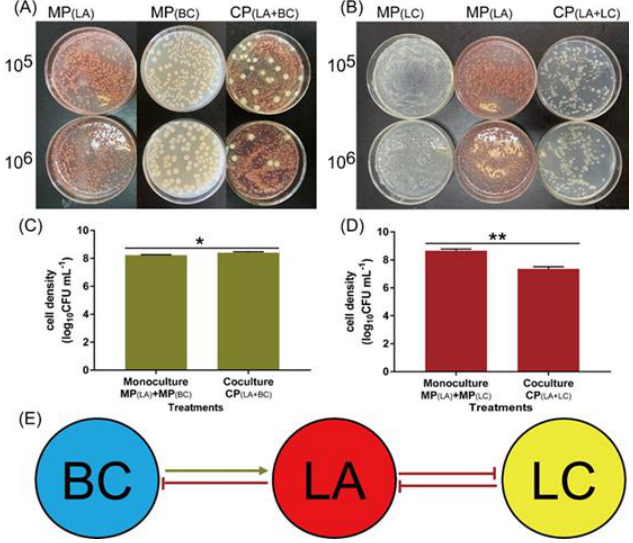
Figure 1. Determination of pairwise interactions between bacterial co-culture (inter-genus and intra-genus). Inter-genus co-culture assay ( A ), intra-genus co-culture assay ( B ), cell density of inter-genus co-culture assay ( C ), cell density of intra-genus co-culture assay ( D ), and network diagram showing the strength and directionality of pairwise interaction between different biocontrol agents ( E ). Significance differences among treatments is assessed accoriding to Student’s t-test at *p < 0.05 and **p < 0.001.